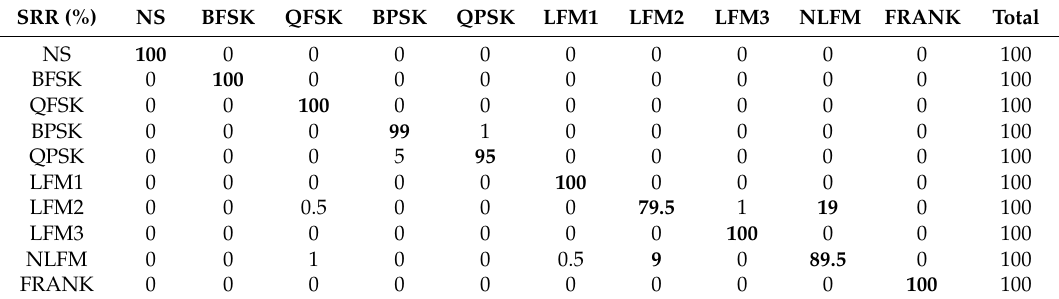
Table 2. Confusion matrix of SRR on LFMs with different slopes at −2 dB.